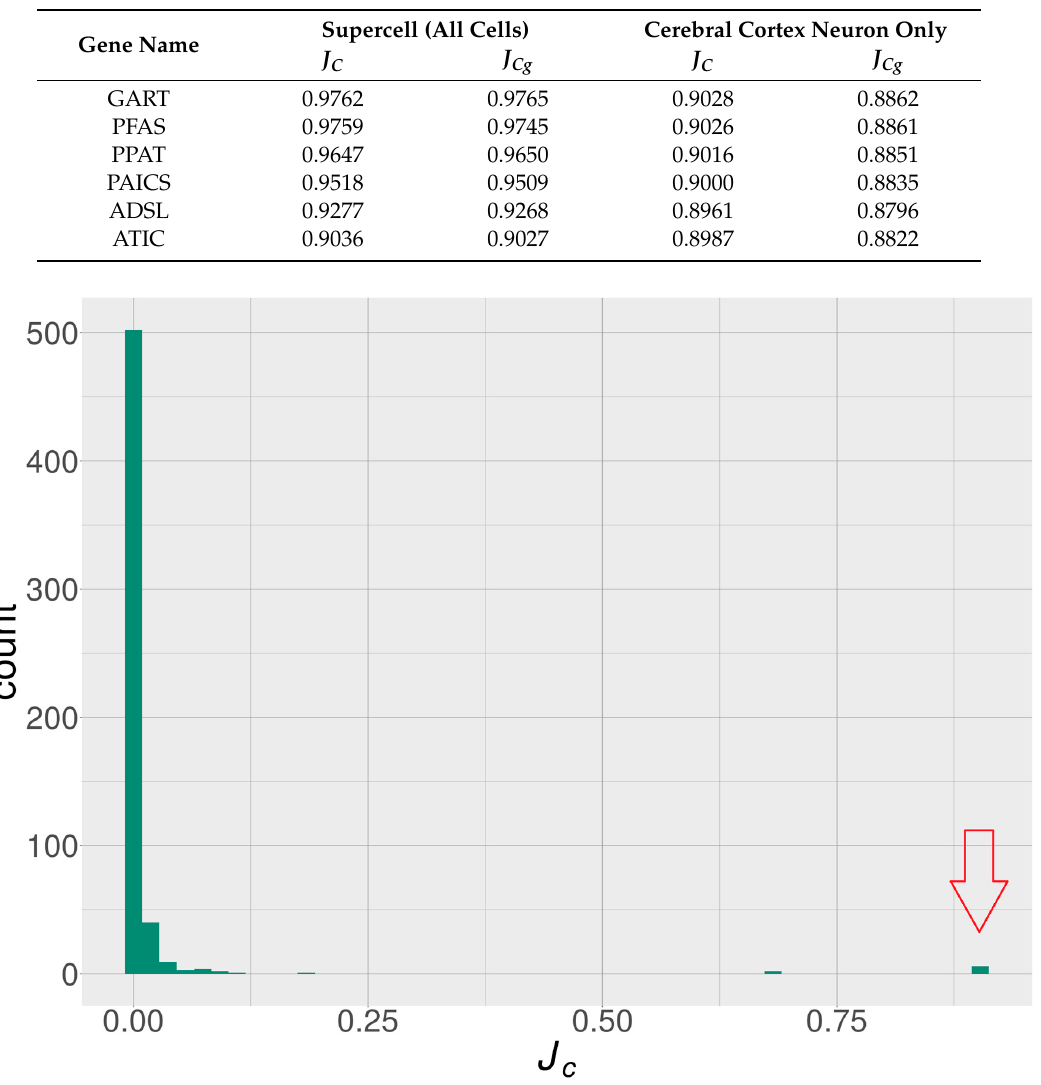
blocked metabolite set associated with folate deficiency. J C , Jaccard coe ffi cient; J Cg , generalized Jaccard coe ffi cient (for definition see methods).